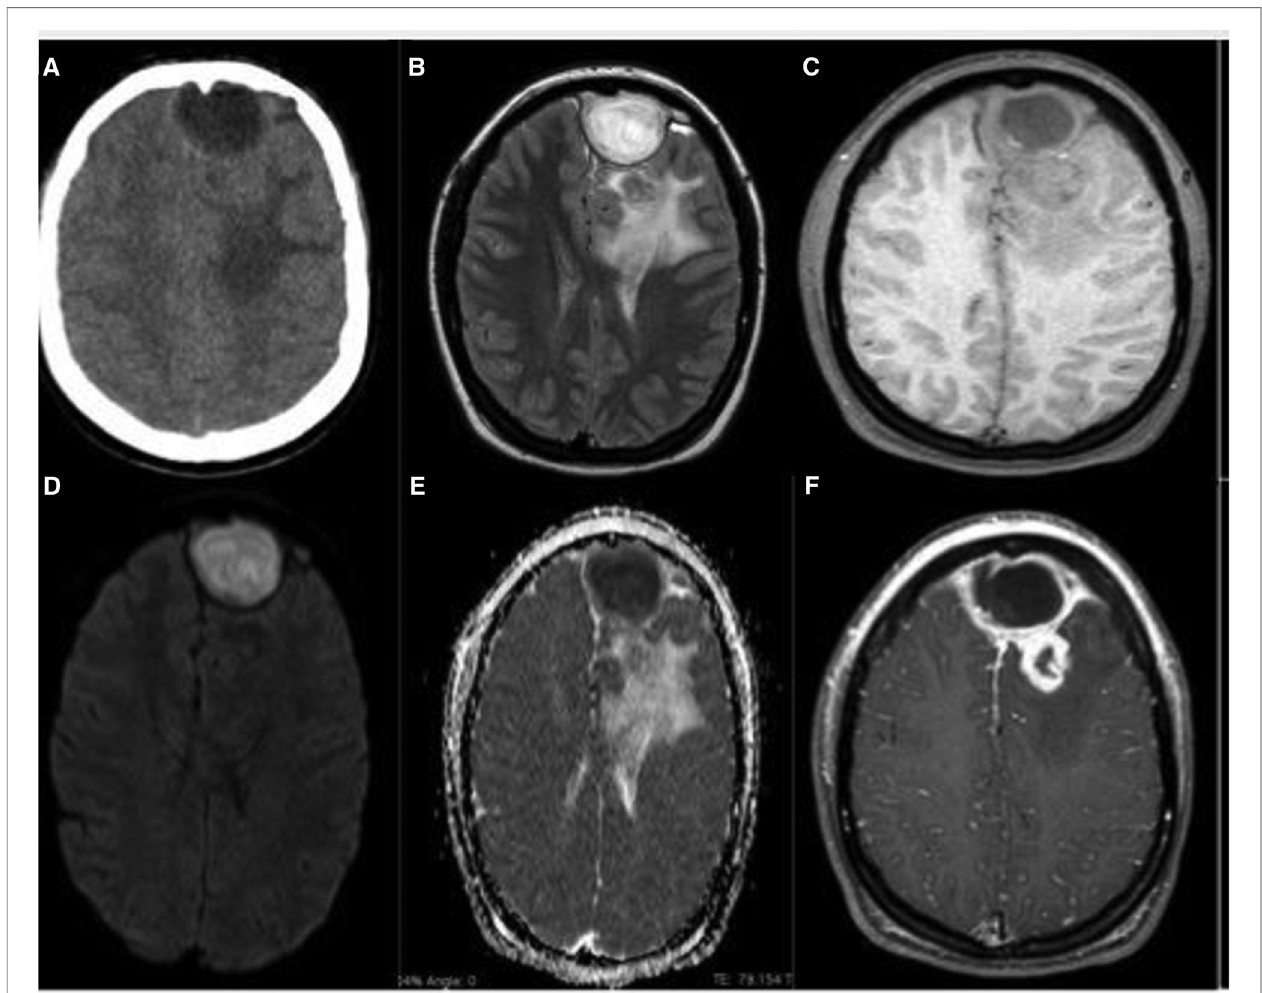
FIGURE 2 | ( A ) Skull CT, without contrast, axial section, evidencing frontal extra-axial lesion, in left paramedian situation and hypoattenuation in the white matter of the left frontal lobe; ( B ) brain MRI, T2/FLAIR, axial, shows better the extra-axial expansive formation, located in the left anterior frontal pole, rounded, with apparent capsule, promoting compressive effect on the adjacent parenchyma, besides evidencing in adjacent frontal lobe small intraparenchymal lesion surrounded by important edema; ( C ) MRI of the brain, T1 after axial contrast, with important peripheral enhancement of both the extra-axial lesion (including with important enhancement of the locoregional meningeal plane) and intra-axial; ( D ) (DWI, axial section) evidences important central restriction of the extra-axial lesion with corresponding signal loss on the ADC Map ( E ) being compatible with